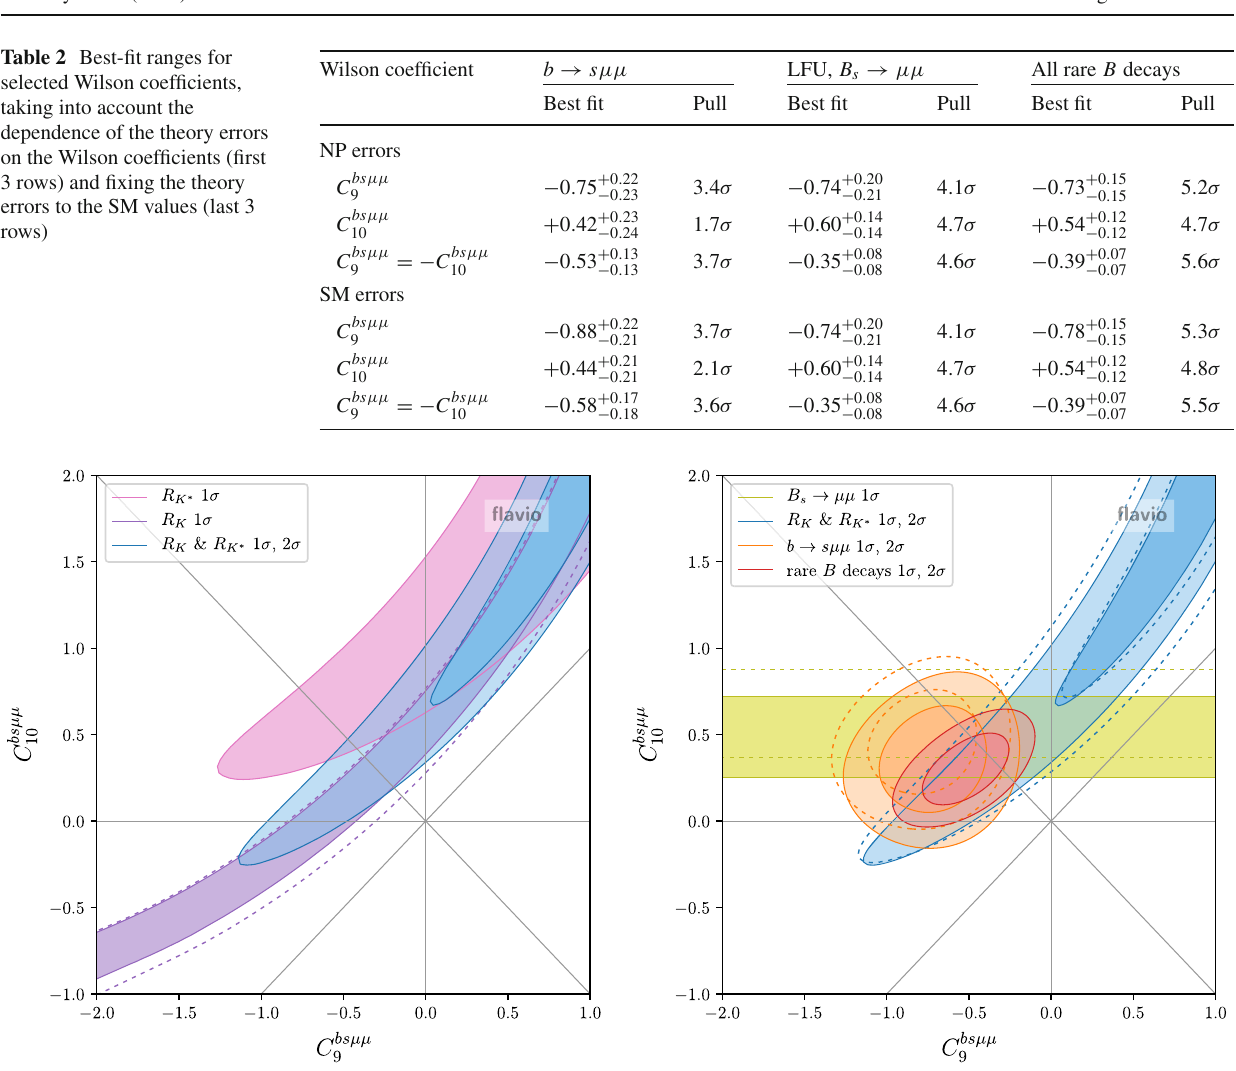
μμ μμ vs. C bs . Left: LFU ratios only. Right: Combination of LFU ratios, combination of 9 10